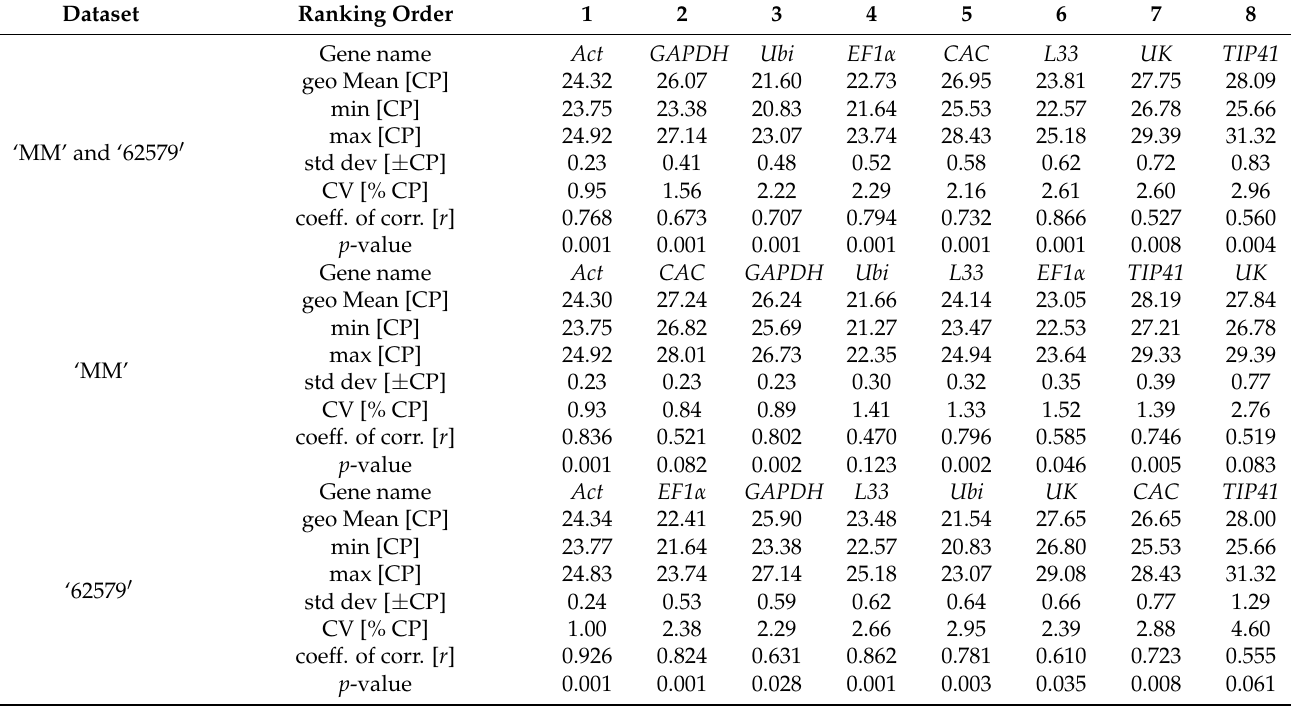
Table 3. Expression stability of eight reference genes was analyzed by